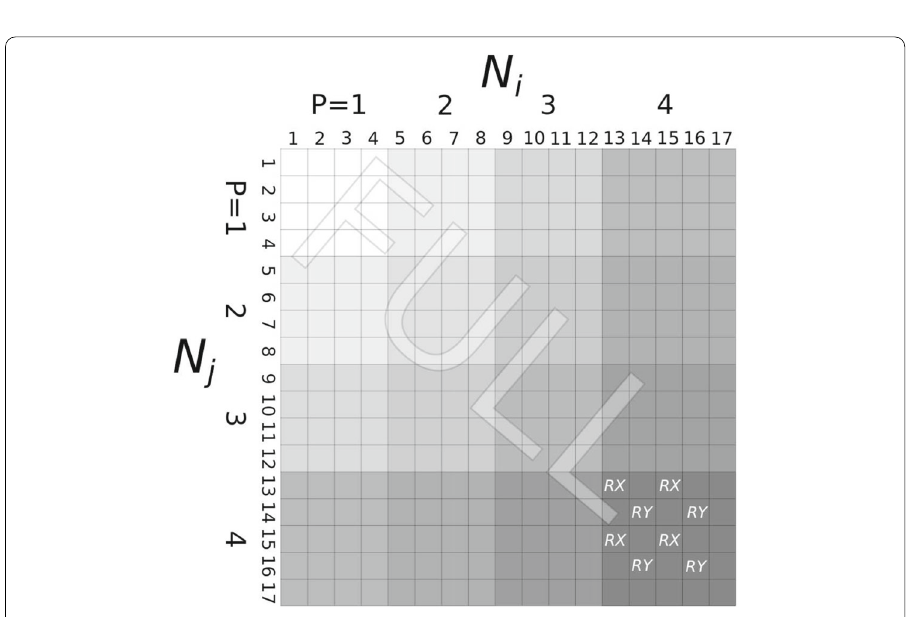
Fig. 5 Reduced integration scheme for an hierarchical element with p = 4. “RX”: reduced integration in the ξ direction; “RY”: reduced integration in the η direction; “FULL”: full integration in both directions